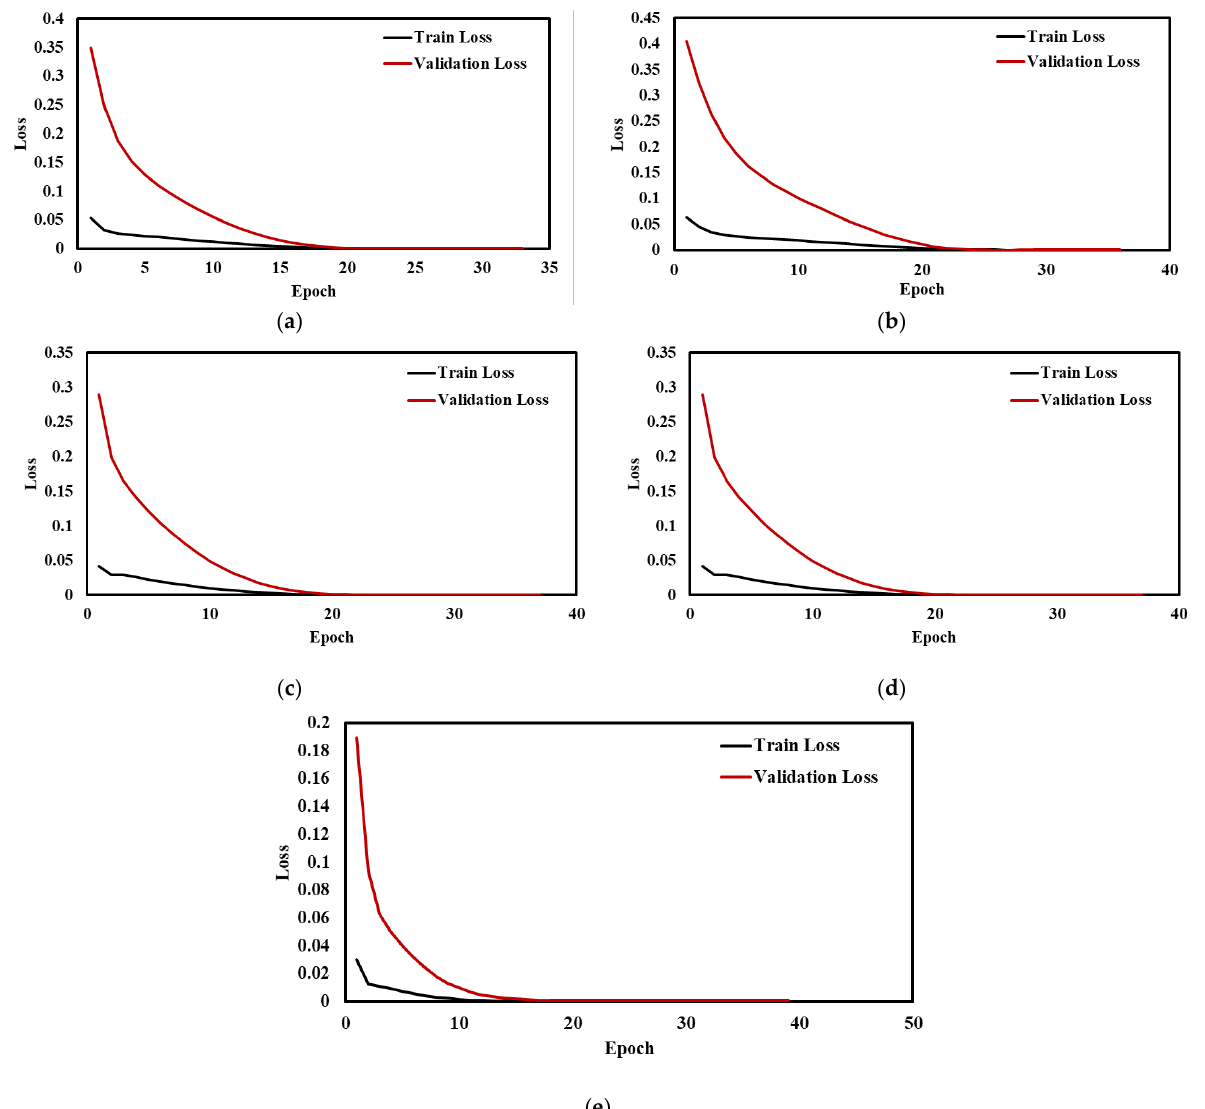
Figure 16. Training loss and validation loss vs No of epochs at ( a ) Baseline ( b ) 5 mm ( c ) 10 mm ( d ) 15 mm ( e ) 20 mm.